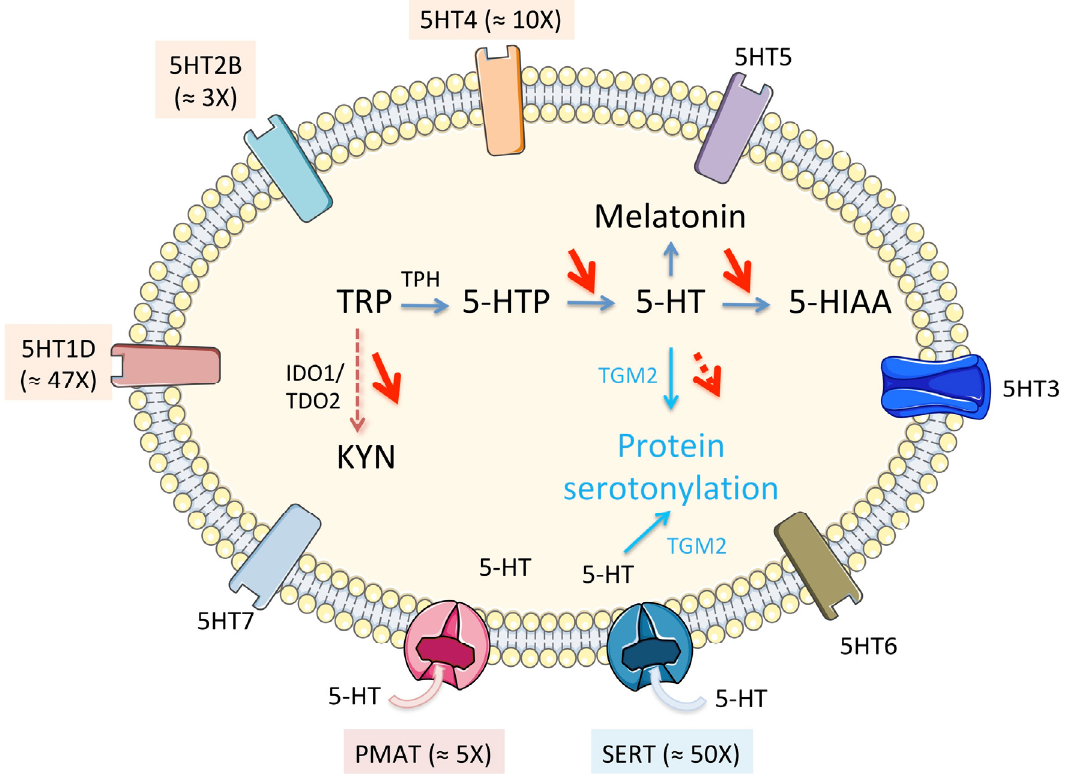
Figure 3. Schematic variations of the seven families of 5-HT receptors (5HT1 to 7), which are a group of G protein coupled receptors (all but 5-HT3) and ligand gated ion channel (5-HT3), and transporters (SERT and PMAT) in the cell membrane. SERT ( SLC64A ) is specific for serotonin while PMAT ( SLC29A4 ) is a polyspecific organic cation transporter, notably for organic monoamines. PMAT is capable of transporting 5-HT through the plasma membrane, but at a much-reduced capacity as compared to that of SERT. In parentheses, ≈ xX indicates the extent of overexpression in HB compared to non-tumoral